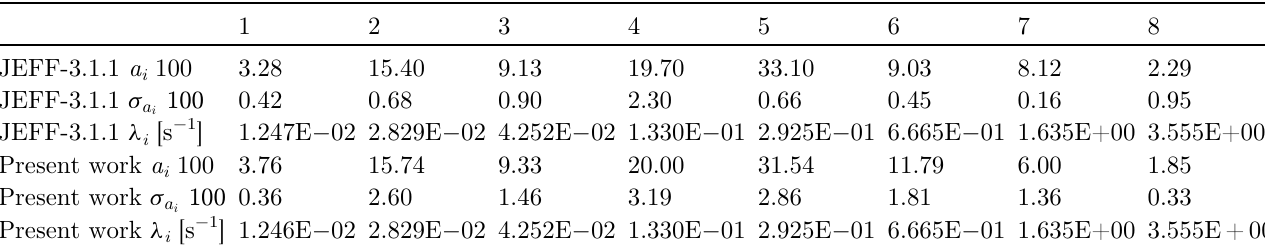
Table 1. Abundances and decay constants.